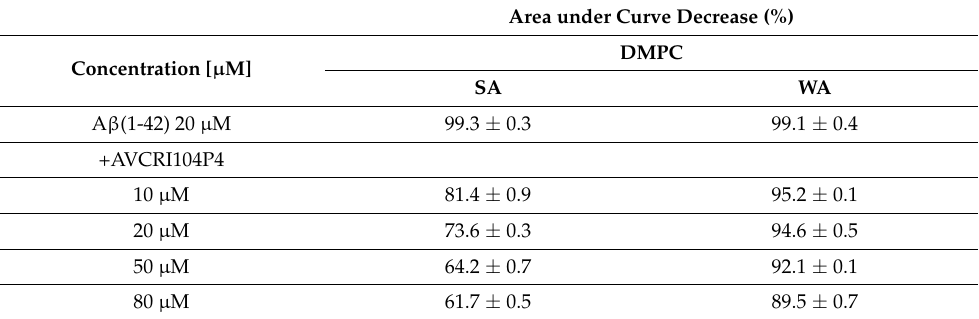
Table 3. Decrease in the area under the curve (%) in the (SA) small-angle and (WA) wide-angle reflections of DMPC and DMPE by the effect of 20 µ M A β (1-42) and AVCRI104P4 solutions. Percentages obtained from the analysis of microdensitograms from X-ray diffraction patterns of DMPC and DMPE in water and incubated with 20 µ M A β (1-42) and AVCRI104P4 solutions.